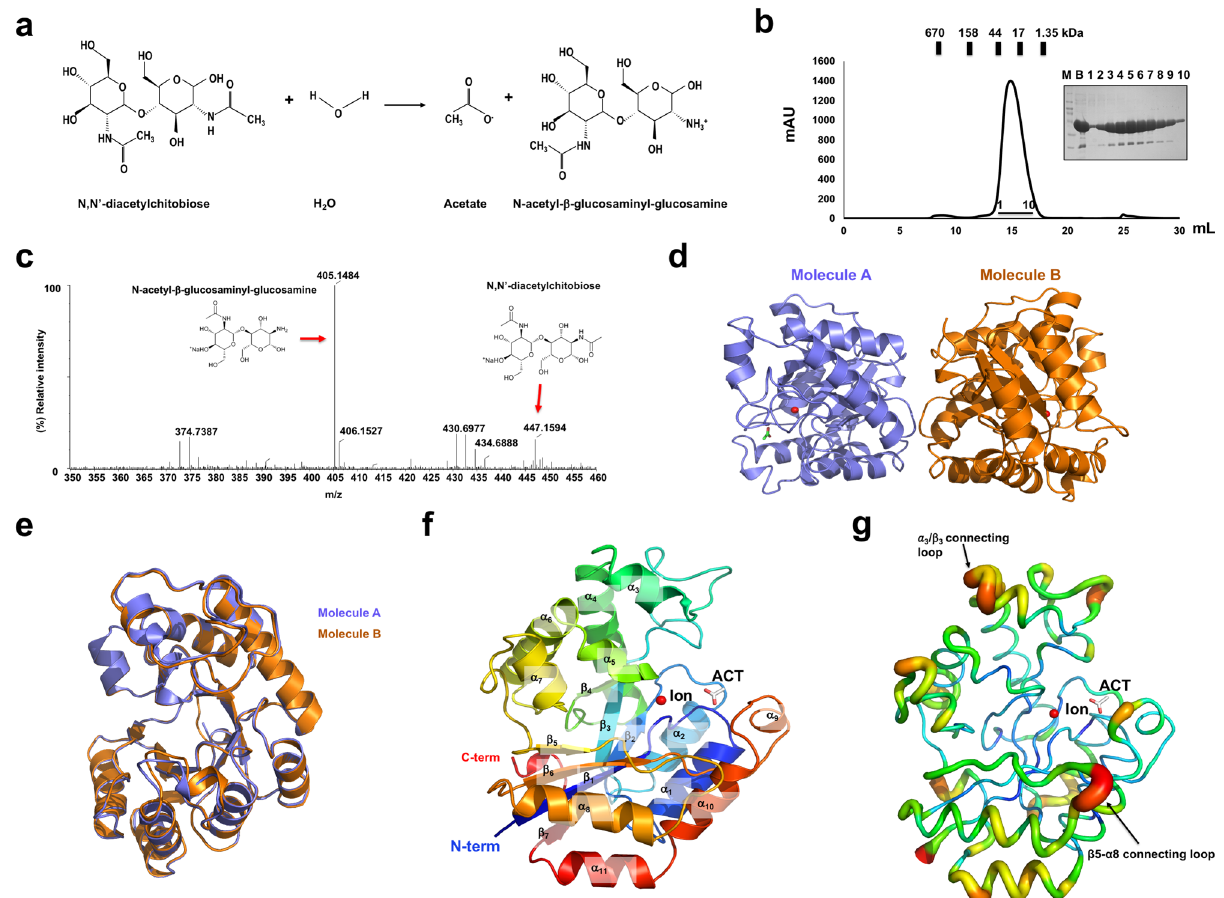
Fig. 1 Crystal structure of ChbG from Klebsiella pneumoniae (kpChbG). a Catalytic reaction of ChbG. b Size-exclusion chromatography (SEC) of Ni 2 + - af fi nity puri fi ed ChbG. Loaded fractions are indicated by the horizontal black bar. Inset: SDS-PAGE assessment of purity. M: size marker and B: before SEC loading. c ESI-MS analysis of deacetylation of N,N ’ -diacetylchitobiose ((GlcNAc) 2 ) to N-acetyl- β -glucosaminyl-glucosamine (GlcN-GlcNAc) by kpChbG. d Cartoon representation of two kpChbG molecules (molecule A and B) presented in an asymmetric unit. e Superposition of the structures in one asymmetric unit. f Rainbow-colored cartoon representation of monomeric kpChbG. The polypeptide chain from the N-terminus to the C-terminus is colored blue to red. Helices and sheets are labeled α and β , respectively. ACT represents acetate and Ion is the metal ion. g Putty representation showing B - factor distribution in the order of B -factor values using rainbow colors (red to